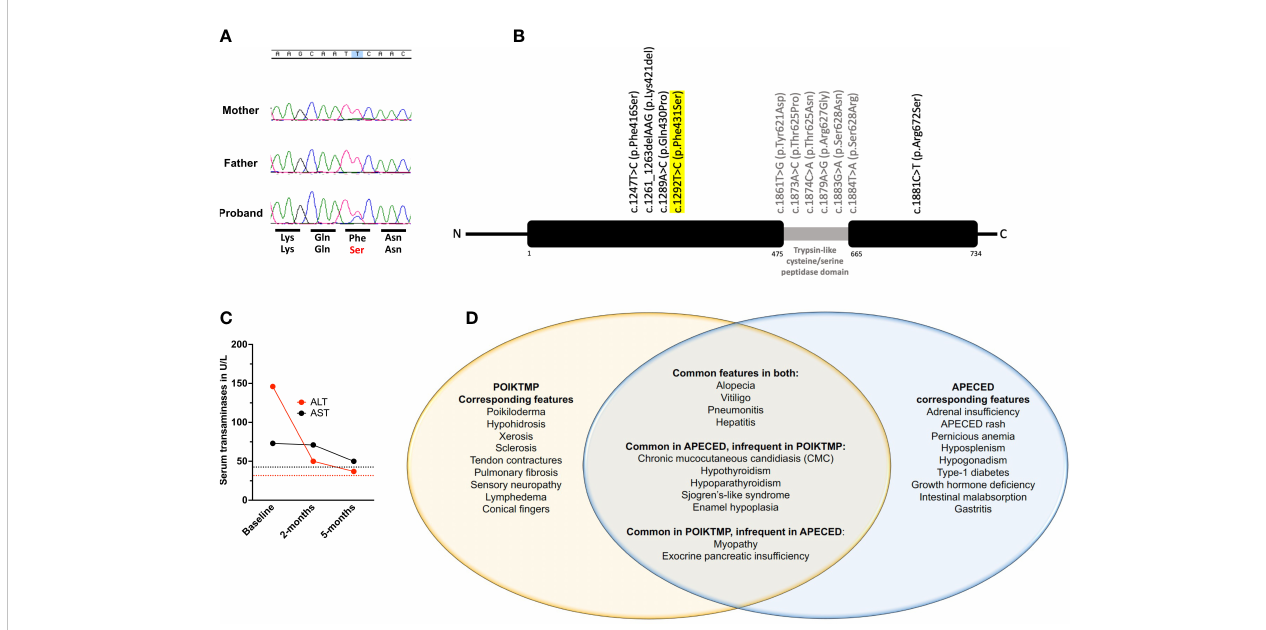
FIGURE 4 Genetic, clinical, and treatment response characteristics of our patient. (A) Chromatograms of FAM111B sequencing on our patient and his mother and father shown over corresponding normal amino acid sequence (top row) with patient ’ s missense change displayed in red (bottom row). (B) Schematic of the FAM111B gene demonstrating all previously reported variants and their location along with our patient ’ s variant that is highlighted in yellow. (C) Temporal evolution of serum transaminase levels. ALT (red) and AST (black) are increased at baseline and decline nearly to normal levels by 5-months following initiation of azathioprine treatment. Red and black dotted lines represent the upper limit of normal range for ALT and AST, respectively. (D) Venn diagram depicting our patient ’ s disease manifestations, thereby demonstrating the shared and distinct clinical features between POIKTMP and APECED